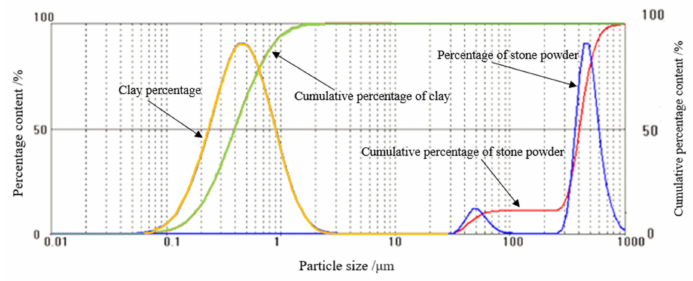
Figure 6. Particle size distribution curves of clay and stone powder.